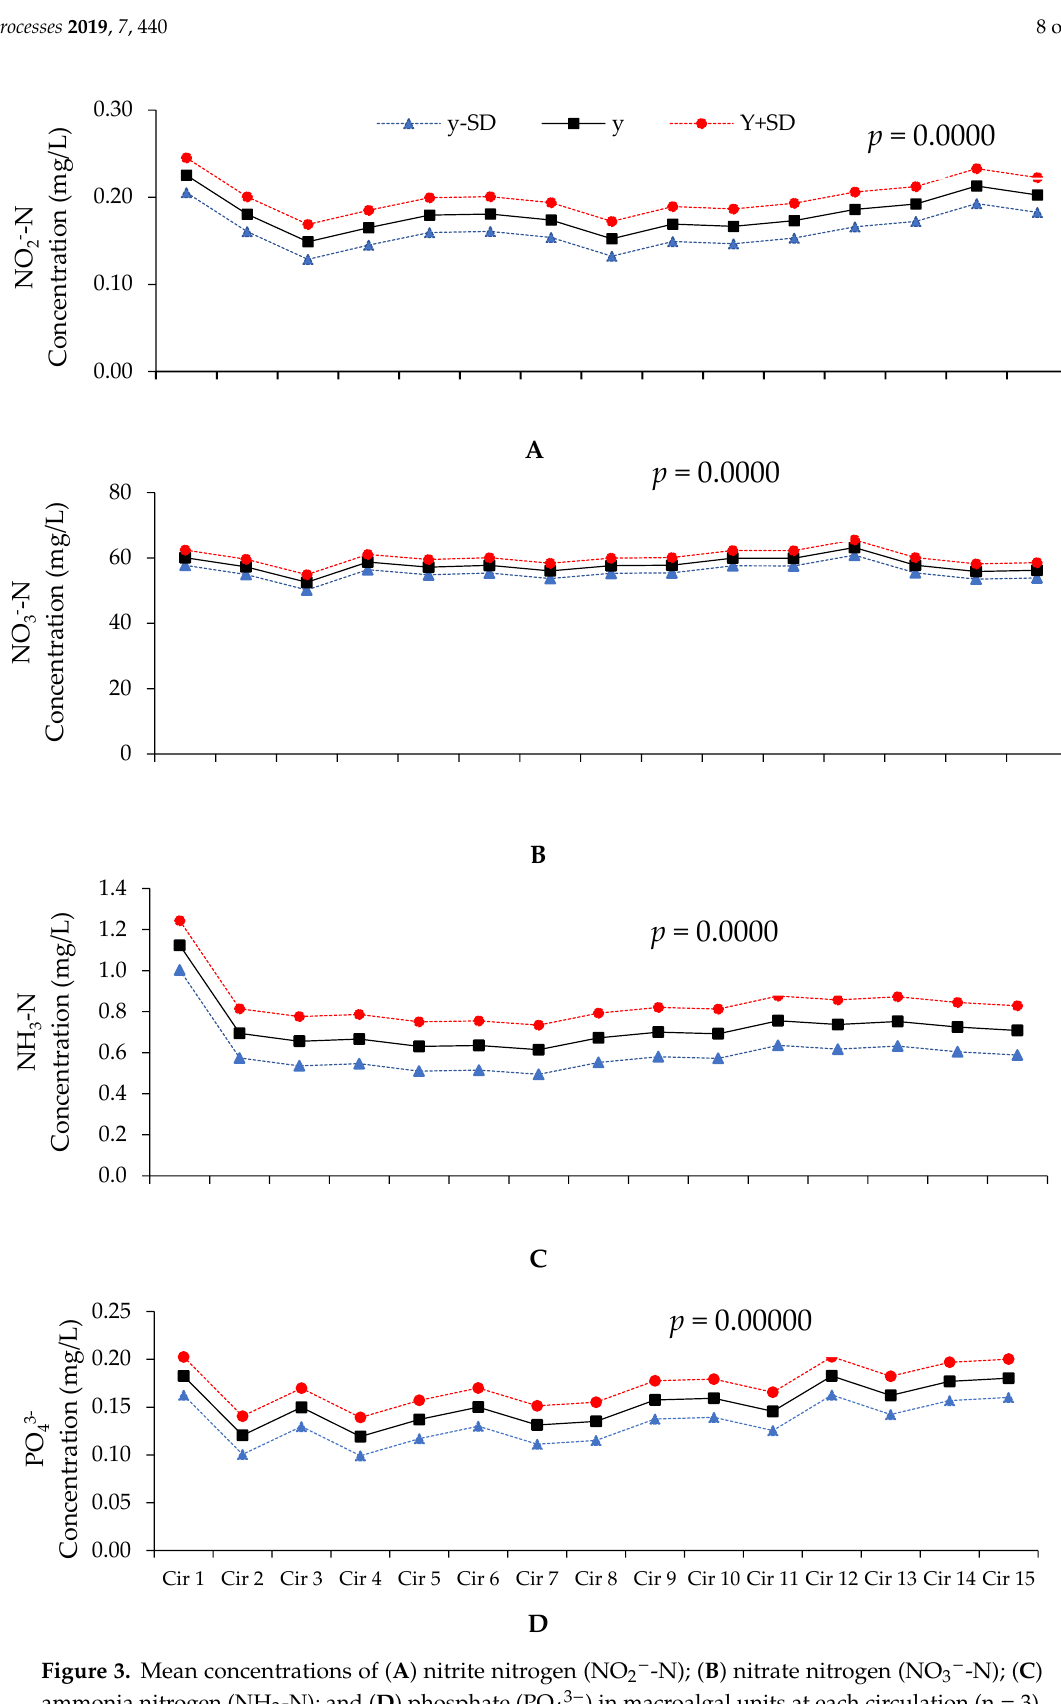
Figure 3. Mean concentrations of ( A ) nitrite nitrogen (NO 2 − -N); ( B ) nitrate nitrogen (NO 3 − -N); ( C ) ammonia nitrogen (NH 3 -N); and ( D ) phosphate (PO 43 − ) in macroalgal units at each circulation (n = 3). The p values are for ANOVA.